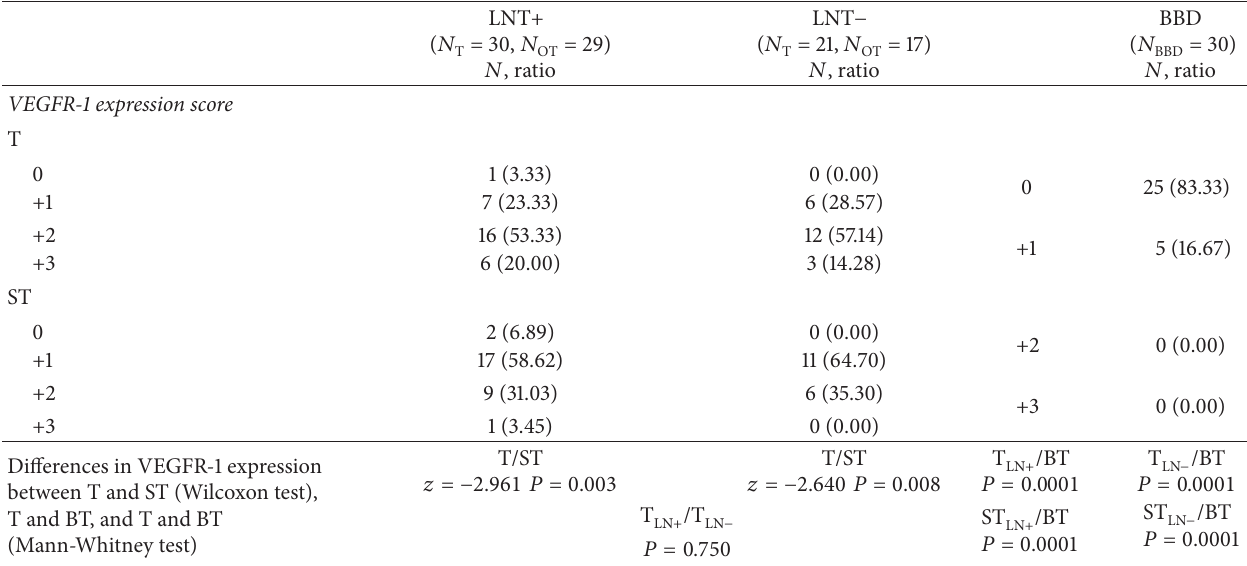
Table 2: The final score of VEGFR-1 expression in breast cancer patients and in patients with benign breast